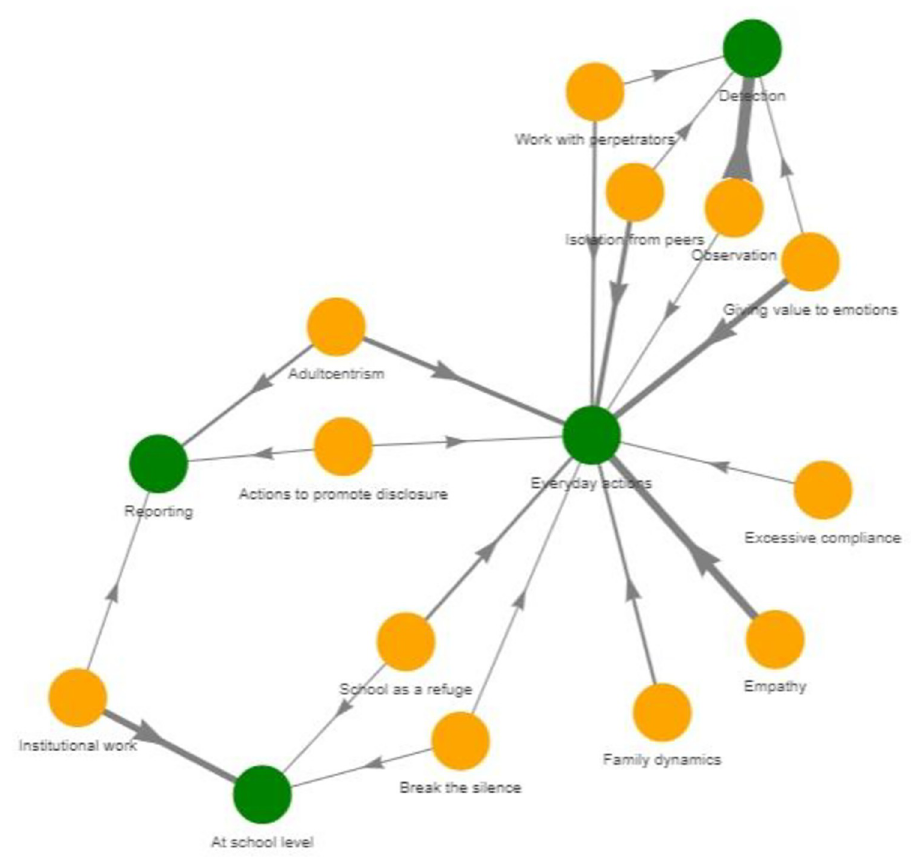
Fig 2. Network analysis linking actions proposed by school staff (yellow nodes) with emerging categories of child sexual abuse victims (green nodes). Edges’ widths are proportional to the number of links. Interactive alternative versions of this plot are provided as supplemental material in https://osf.io/7q3rt/.